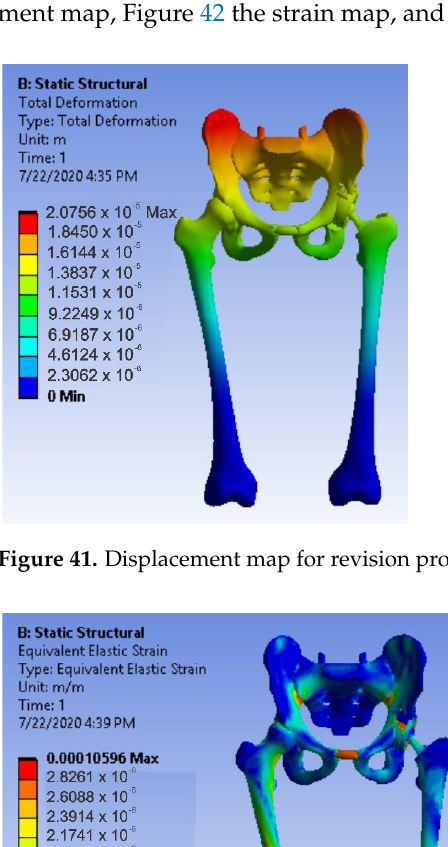
Figure 43. Stress maps for revision prosthesis with titanium augment. 3.6. Virtual Hip Joint Testing with Revision Prosthesis with Morcellated Graft and Reconstructive Mesh Subjected to Normal Gait Loading The hip joint model with revision prosthesis with morcellated bone graft and recon- structive mesh was loaded into Ansys Workbench, as shown in Figure 44. Figure 44. The analysed model loaded in Ansys Workbench.